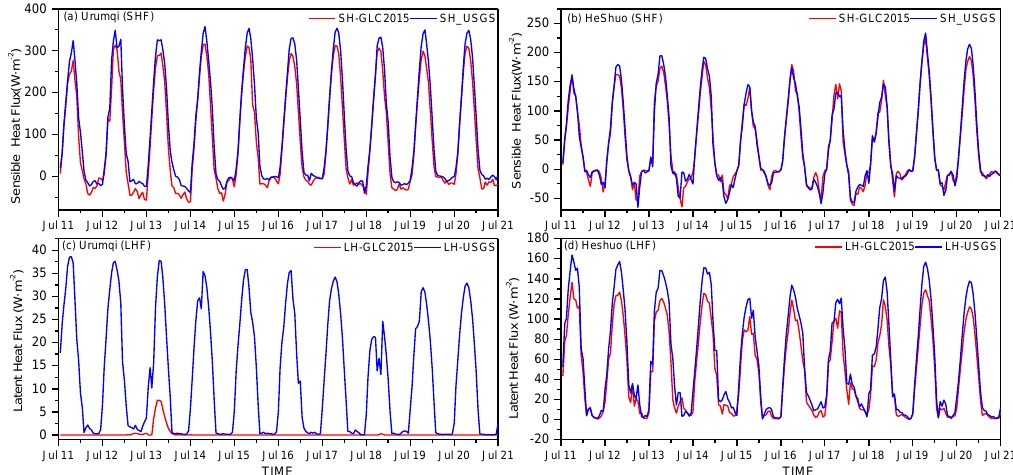
Figure 6. Sensible heat flux ( SHF ) at ( a ) Urumqi and ( b ) Heshuo, and the latent heat flux ( LH ) at ( c ) Urumqi and ( d ) Heshuo ( d ). Both GLC2015 (red line) and USGS (blue line) are plotted.